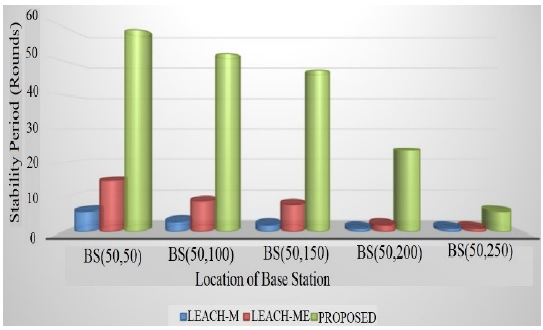
Fig. 18. Stability Period with Varying Position of BS